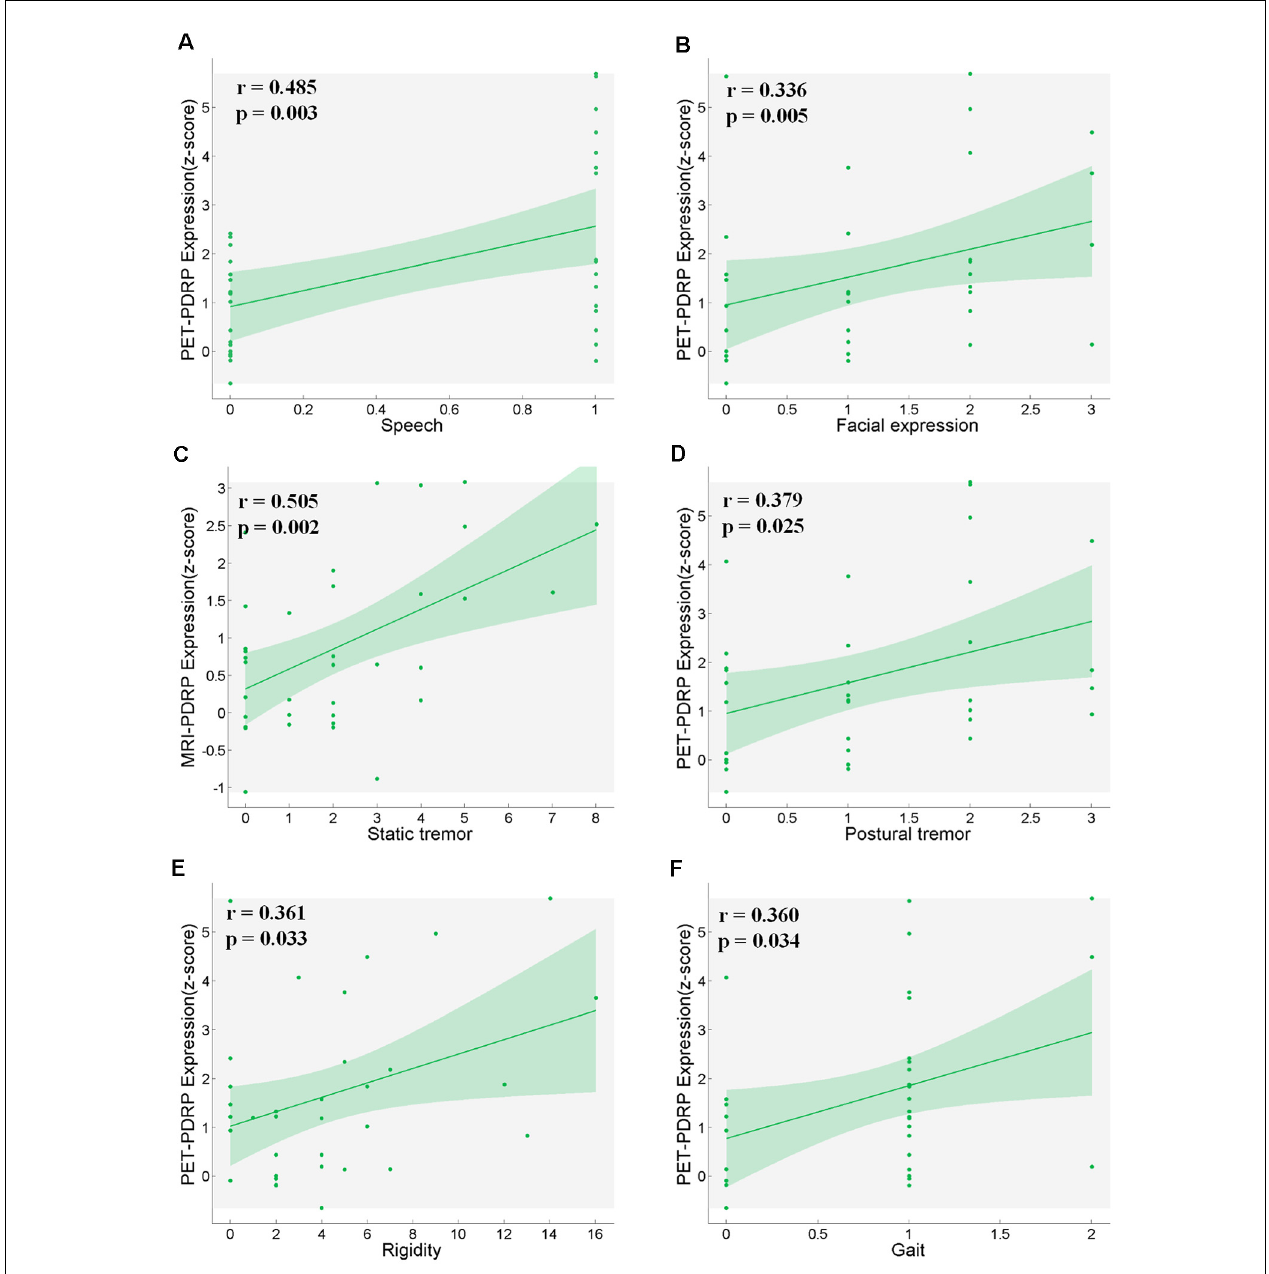
FIGURE 5 | PET-PDRP expressions in PD patients correlated with their levels of (A) speech, (B) facial expression, (D) postural tremor, (E) rigidity and (F) gait. MRI-PDRP expressions in PD patients correlated with the levels of (C) static tremor. Shaded areas represent 95% confidence of